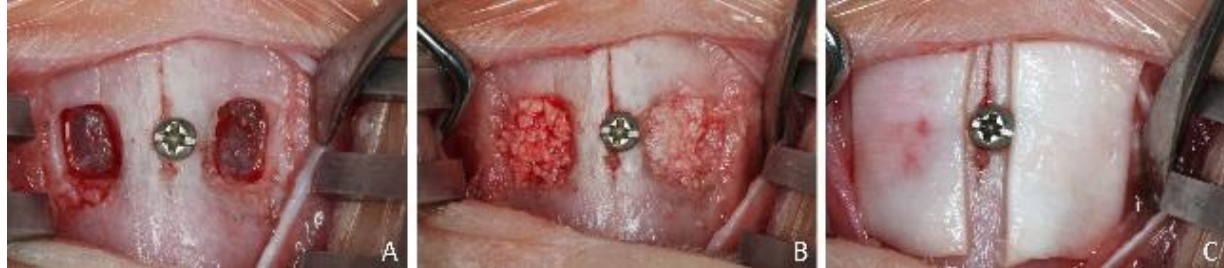
Figure 1. View of the clinical procedures in the experimental region. ( A ) A 3.5–4 mm antrostomy was prepared on both sides, laterally to the nasal-incisal suture, and anteriorly to the nasal-frontal suture. ( B ) Deproteinized bovine bone mineral granules either 0.250–1.0 mm or 1.0–2.0 mm were randomly allocated and grafted within the elevated space in similar quantity. ( C ) The antrostomies were subsequently covered with collagen barriers.